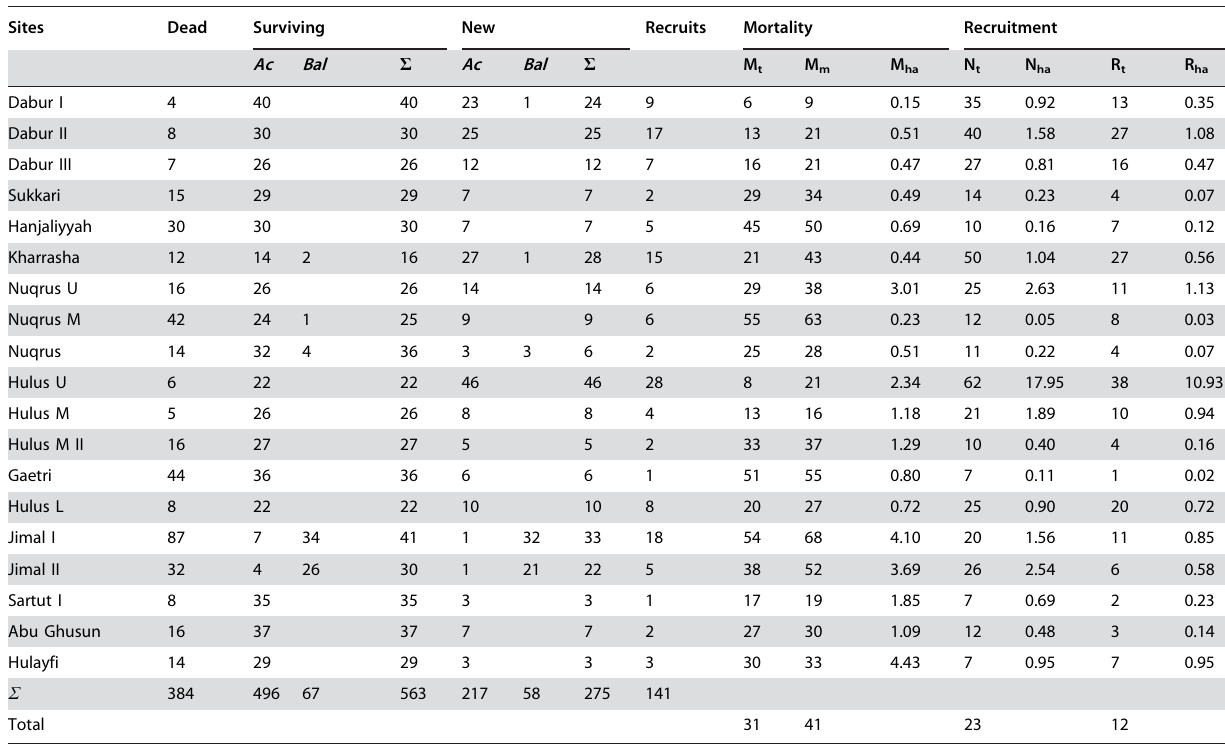
Table 3. Summary of change categorization for sites, including mortality and recruitment estimates. .. ... .... ... ... .... ... ... .... ... ... .... ... ... .... ... ... .... ... ... .... ... ... .... ... ... .... ... ... .... ... ... .... ... ... .... ... ... .... ... ... .... ... ... .